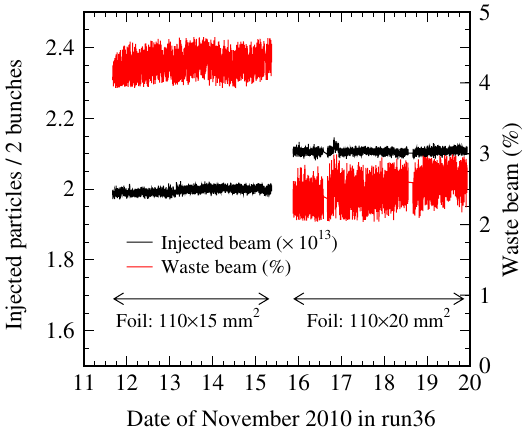
FIG. 13. A trend of the H0CT signal for two cycles in run 36 by using second generation stripper foils with reduced vertical sizes. Mostly because of the unexpected long tails of the injected beam, the waste beam at the H0 dump by using a vertical foil size of 15 mm in the first cycle was found to be an order of magnitude higher than expected as well as observed so far by using the first generation stripper foil. It was then exchanged by a vertical size of 20 mm which could reduce the waste beam by nearly a half but it was still a few times higher than the expected